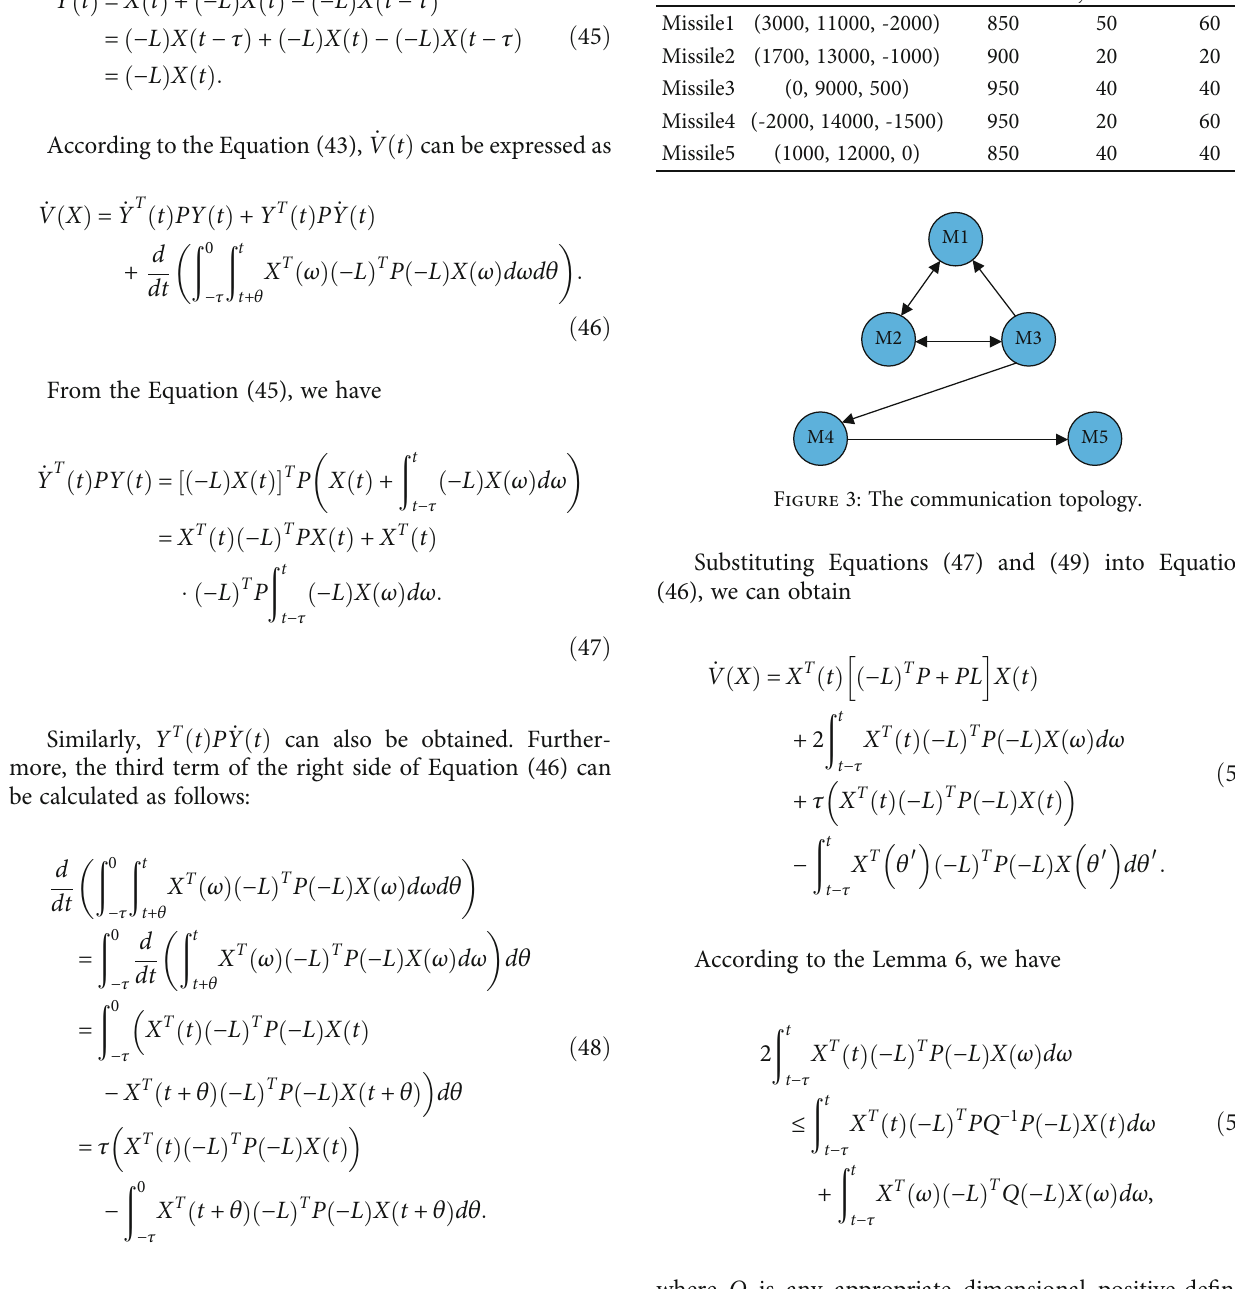
Table 1: Simulation initial conditions for missiles. Missile